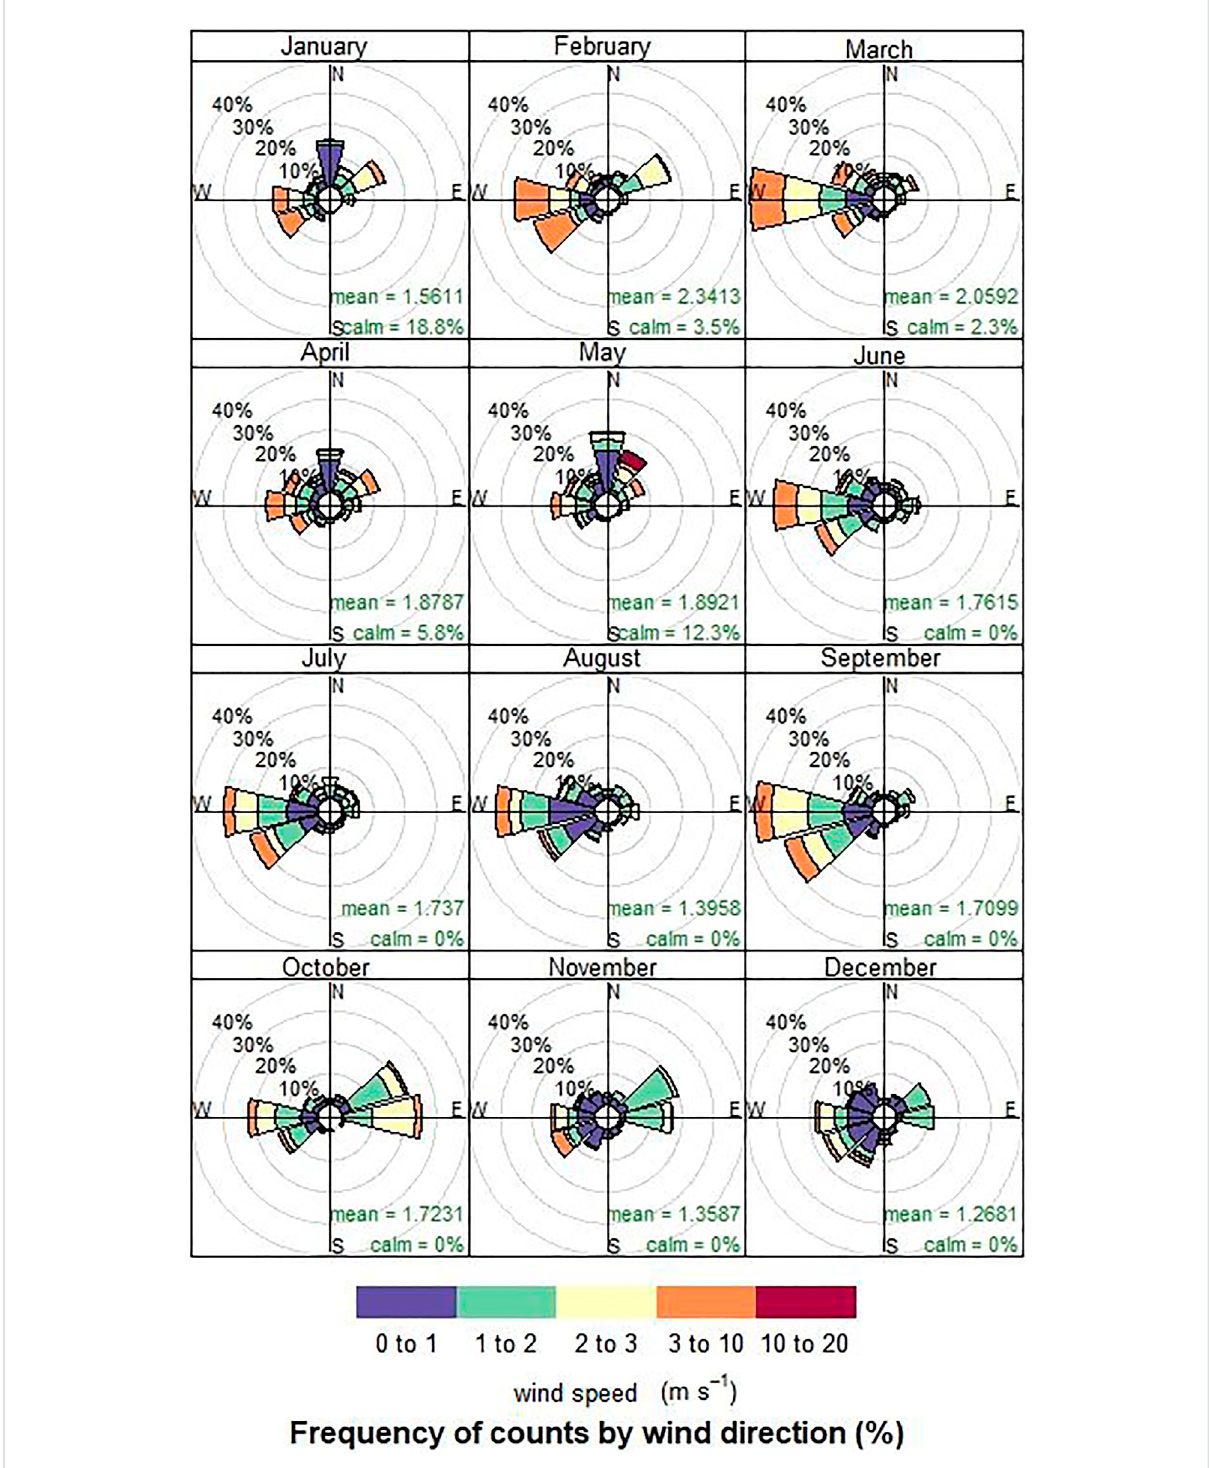
FIGURE 6 Monthly averaged wind roses from the period